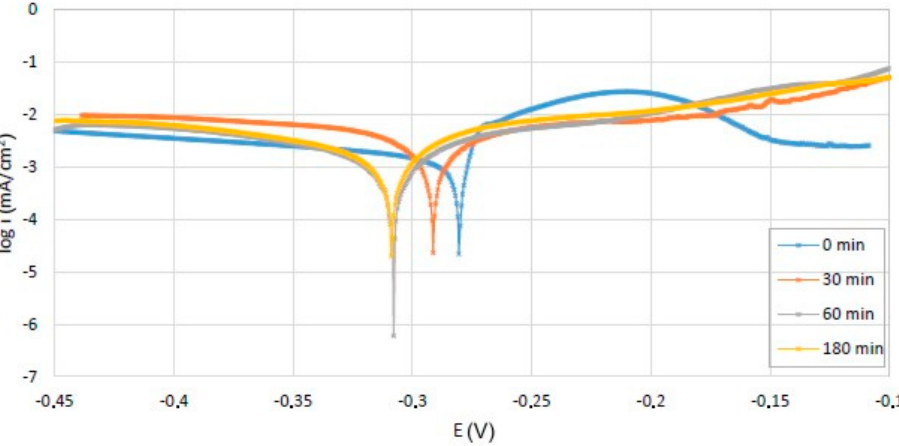
Figure 7. Tafel diagrams for corrosion in solution of 3.5% NaCl for 0, 30, 60, and 180 min.